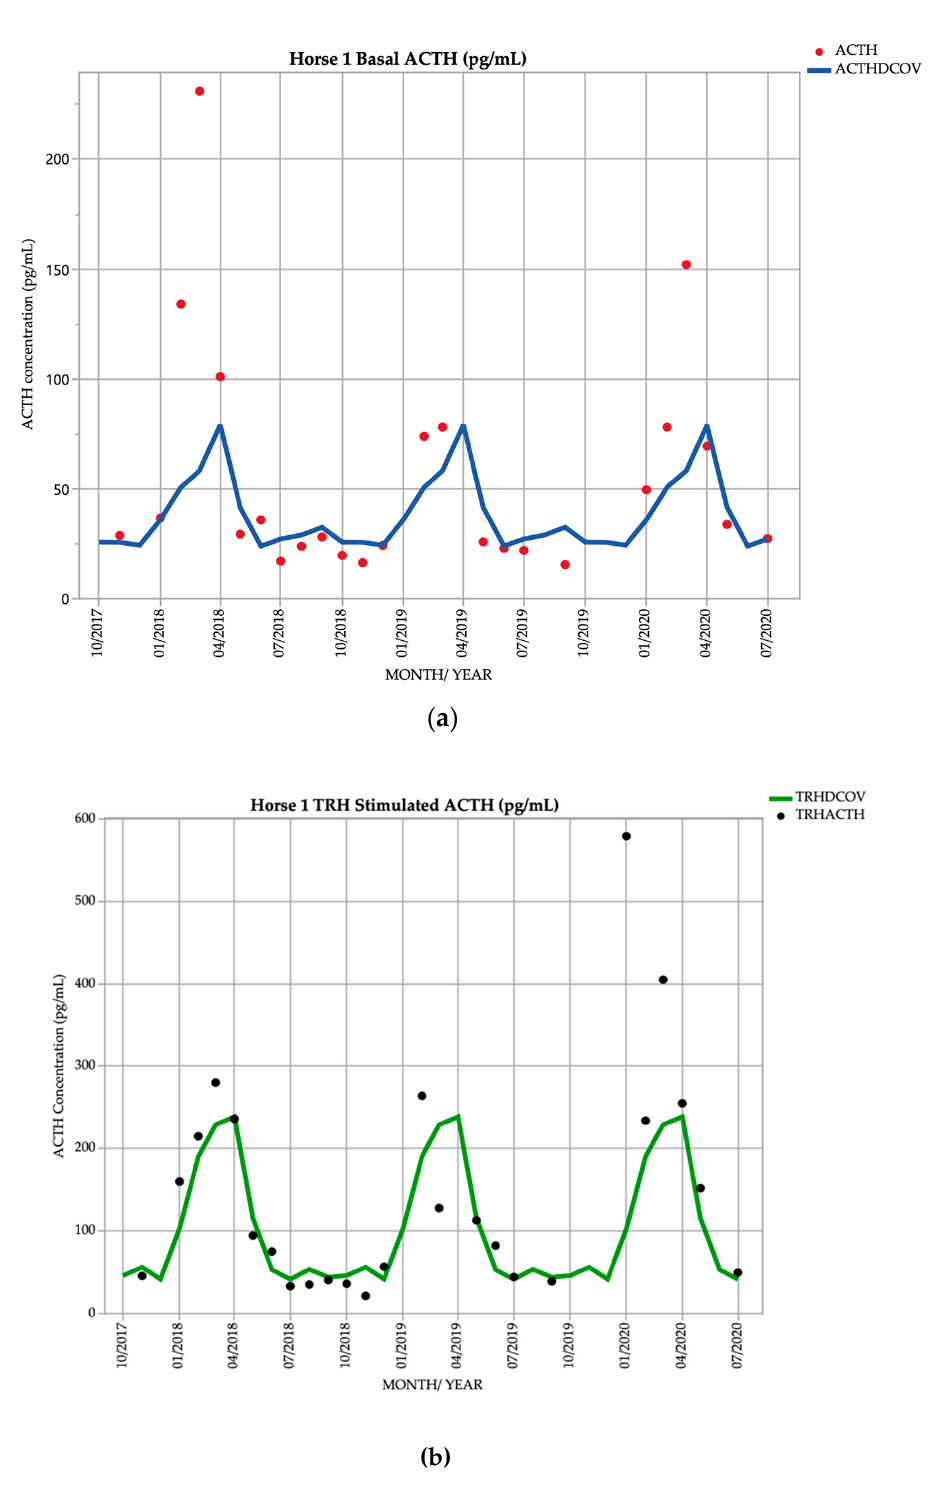
Figure 1. Monthly ACTH concentration (pg/mL) in Horse 1 (26-year-old Stockhorse mare), compared to locally derived, seasonally adjusted DCOV [2]. ( a ) Basal ACTH concentrations (red points) and basal ACTH DCOV (blue line) ( b ) TRH-stimulated ACTH concentrations (black points) and TRH-stimulated ACTH DCOV (green line). Table 2. Hypertrichosis score and interpretation of basal and TRH ‐ stimulated ACTH concentra ‐ tions based on DCOV.